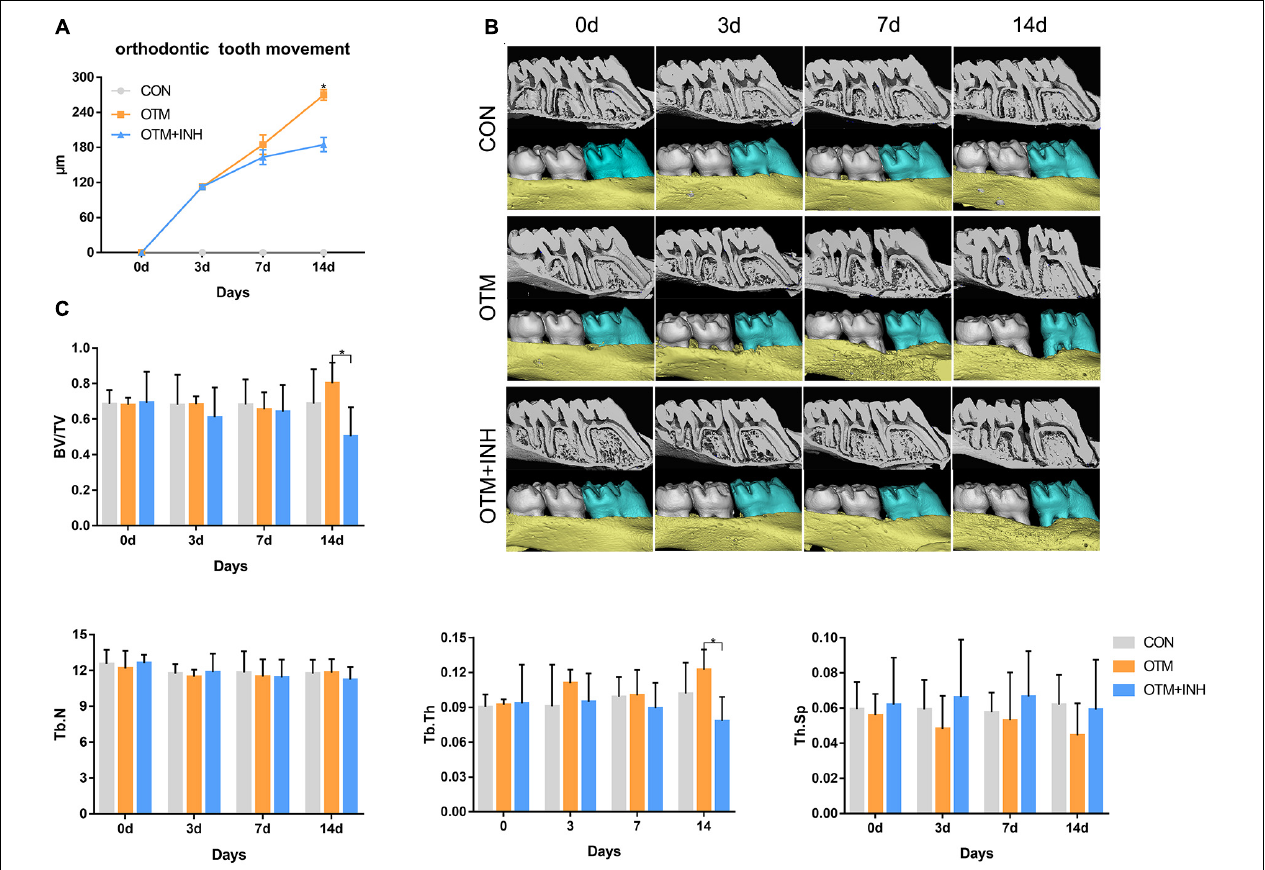
FIGURE 2 | Inhibition of Piezo1 hindered the distance of OTM and decreased bone mass. (A) Micro-CT and three-dimensional (3D) reconstruction images showed the distance of OTM. (B) The distance of OTM from day 0 to day 14. The distance was increased by orthodontic force overtime in the OTM group while declined by GsMTx4 in the OTM + INH group. * p < 0.05, the OTM vs. OTM + INH groups. (C) Parameters including bone volume/total volume (BV/TV), trabecular number (Tb.N), trabecular thickness (Tb.Th), and trabecular spacing (Tb.Sp) were examined from day 0 to day 14. BV/TV and Tb.Th of the OTM group were